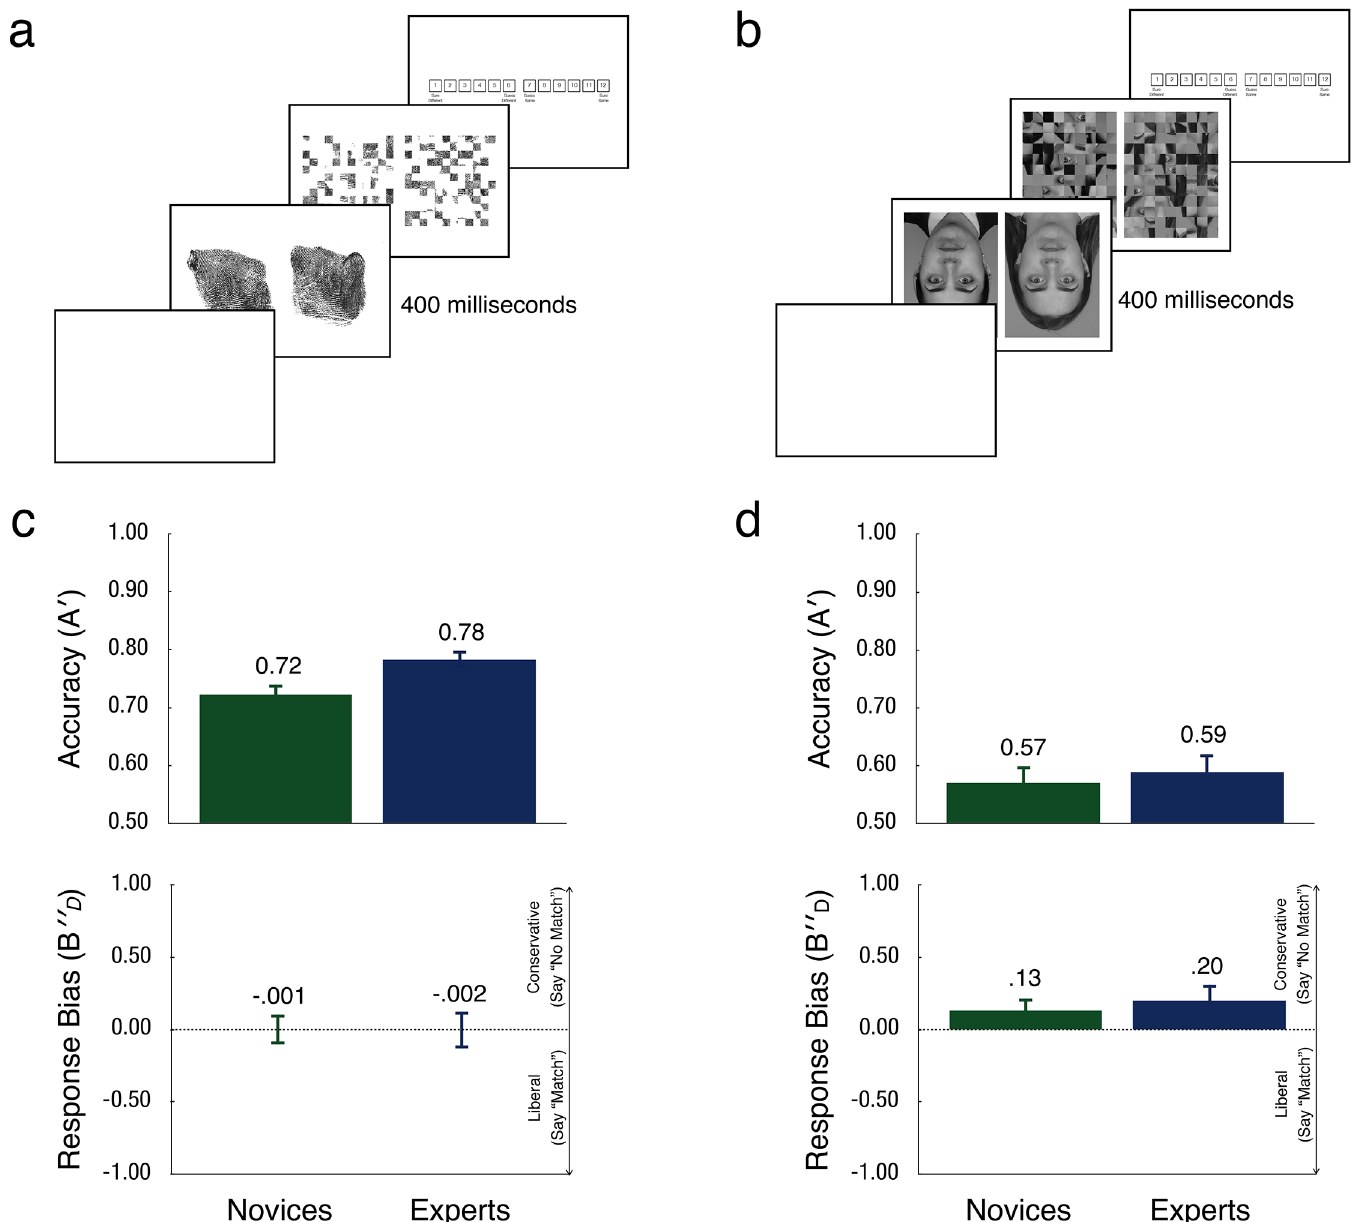
Fig 2. A representation of the fingerprintdiscrimination task sequence(a), and the invertedface discrimination task sequence(b). The mean accuracy ( A 0 ) or discrimination ability for novices (green) and experts (blue) on the fingerprint(c), and face (d) tasks are depicted beneatheach sequence.Error bars show the standard error of the